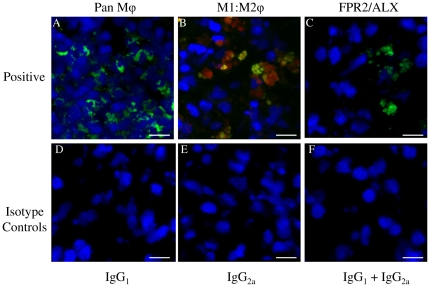
Representative Z stack images of antibody control cryosections of equine spleen.Panel A–C represents positive controls for: (A)CD172a Mϕ (green); (B) Dual antibody labelling with CD14 (M1Mϕ red) and CD206 (M2Mϕ green) showing co-expression of both markers (CD14highCD206high) in splenic monocytes/macrophages; (C) Lipoxin A4 receptor (FPR2/ALX, green). Panel D–F represents negative controls, consisting of murine isotype matched primary control antibodies: (D) IgG1, (E) IgG2a, (F) IgG1 and IgG2a. Blue represents Hoechst nuclear counter stain. Scale bar = 12 µm.